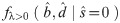
Dynamical phases in recurrent neural networks and characteristic output signals of individual neurons.(A) Two-dimensional phase diagram, showing the fraction of positive Lyapunov exponents fλ>0(b^,d^|s^=0) as a function of the control parameters balance and density, for a constant symmetry parameter s^=0 (Note that in part G, we show the average Lyapunov exponent along a a one-dimensional cut through the 2D phase space of balance and density, for constant density 0.2). In the heat map, dark blue colors indicate fλ>0 ≈ 0, dark red colors fλ>0 ≈ 1. The red region in the center of the phase diagram is the chaotic regime, consistent with the irregular outputs of selected neurons (F). The ‘left’ blue region at negative balance values is the regime of cyclic attractors, often with small period lengths T ≈ 2, as demonstrated with the neuron output (B). The ‘right’ blue region at positive balance values is the regime of fixed points, as exemplified with the constant neuron output (D). Note that, in both cases (B, D) the fraction of positive Lyapunov exponents is zero since the dynamics is non-chaotic, and hence the color coding is identical in both cases. The most interesting dynamics is found at the edges of the chaotic regime (C, E), where one finds cases of periodic behavior with large period length T > 2, periodic behavior with intermittent bursts, decaying oscillatory behavior, and ‘beating’ oscillatory behavior. Note that, the sampled time traces depicted in the figure are from selected neurons, not necessarily from within the same network.